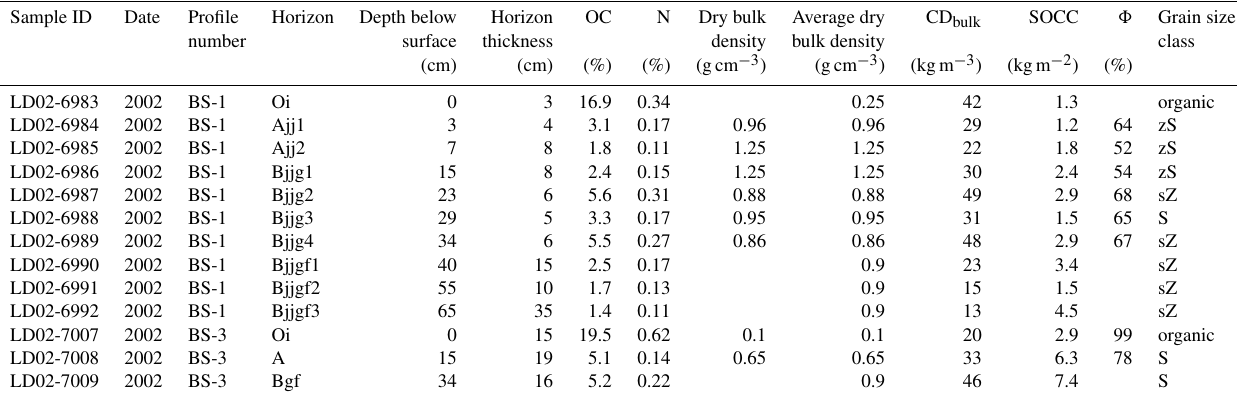
Table F1. Soil data from the BS-1 (polygon rim) and BS-3 (polygon centre) soil pits, which were sampled and had instruments installed in 2002. The location of the soil profiles is described in Wille et al. (2003) and shown in Figs. B8 and B9. Photos of the soil profiles can be seen in Fig. F1 below. Grain size classification is according to Folk (1954), where S is sand, s is sandy, Z is silt, z is silty, M is mud, m is muddy, C is clay, and c is clayey. Other abbreviations used are OC for the mass fraction of organic carbon in soil, N for the mass fraction of nitrogen in soil, CD bulk for the organic carbon density in bulk soil, and SOCC for the soil organic carbon content for each soil horizon. The soil horizon designations are according to the USDA Soil Survey Staff (2010). The BS-1 and BS-2 (polygon slope) soil profiles are classified as Typic Aquiturbels and the BS-3 soil profile is classified as Typic Historthel according to the US Soil Taxonomy (Soil Survey Staff, 2010). Analysis of the physical properties of soil was done according to DIN 19683 (1973). OC and N were determined following the removal of inorganic carbon and dry combustion at 900 ◦ C (DIN ISO